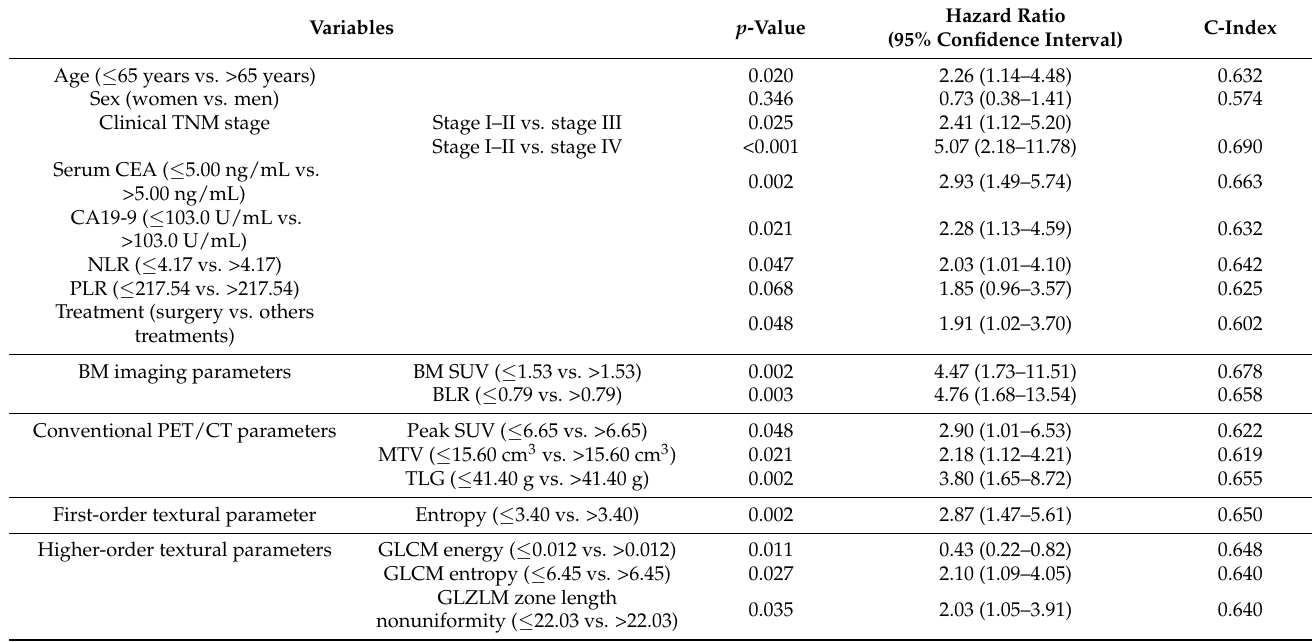
Table 2. Univariable analysis of PET/CT imaging parameters showing statistical significance and clinical factors for predicting overall